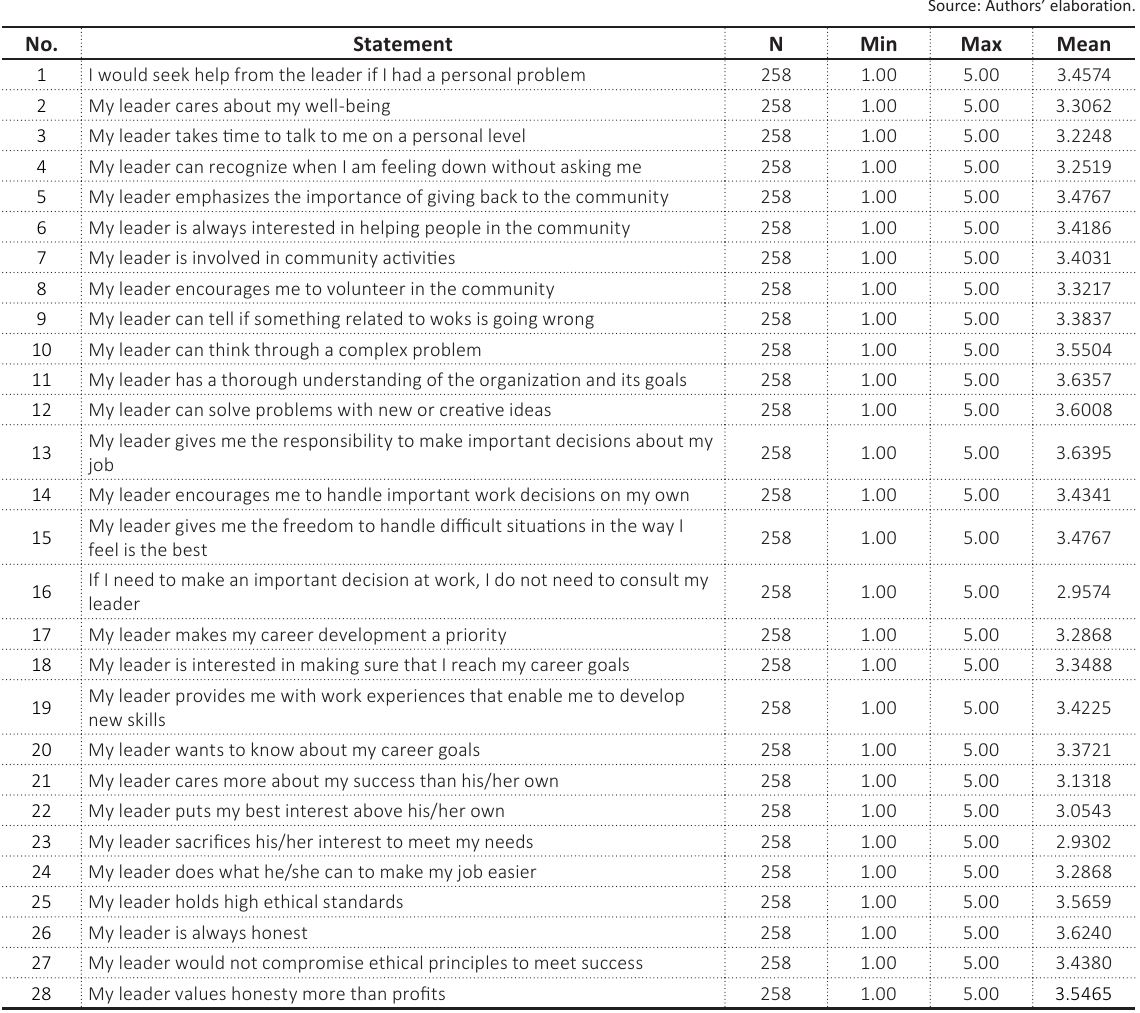
Table 3. Descriptive statistics of the servant leadership variable ( X )